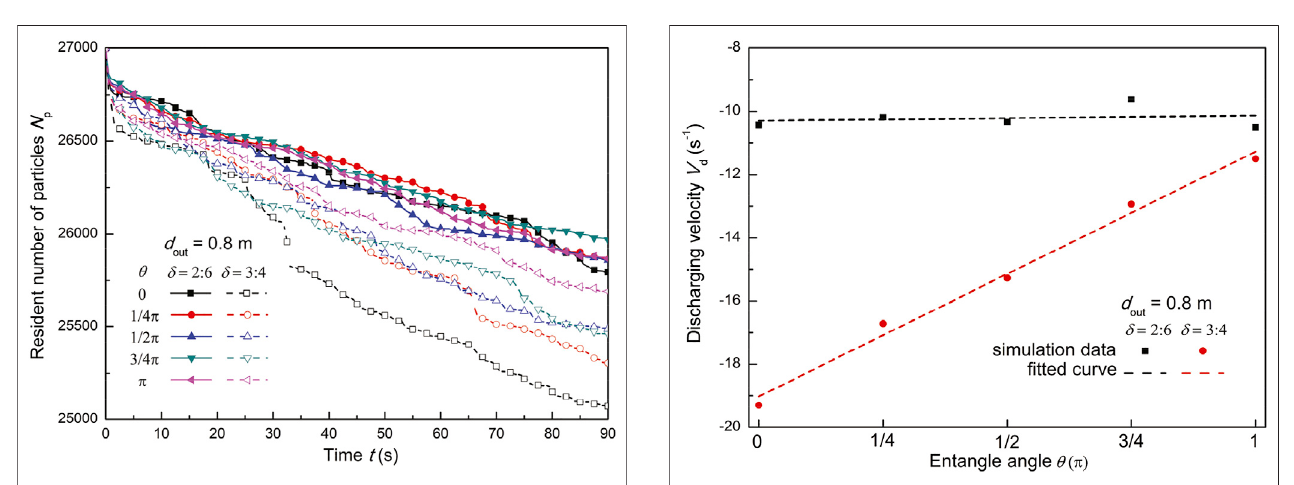
FIGURE 4 | Number of resident particles with different included angles θ of z-particles when d out (cid:1) 0.8 m.